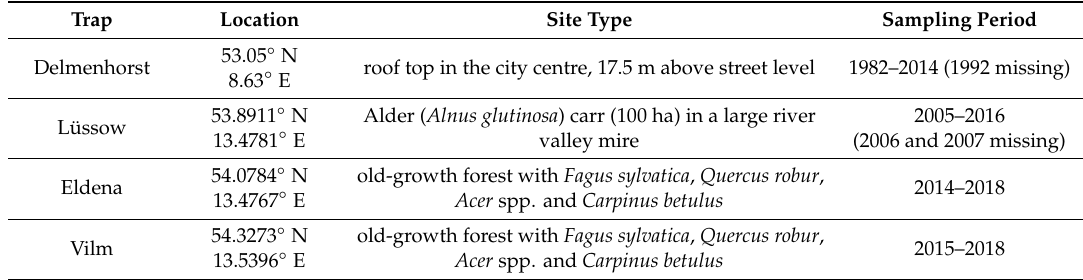
Table 2. Location and details of the pollen trap records used in the present